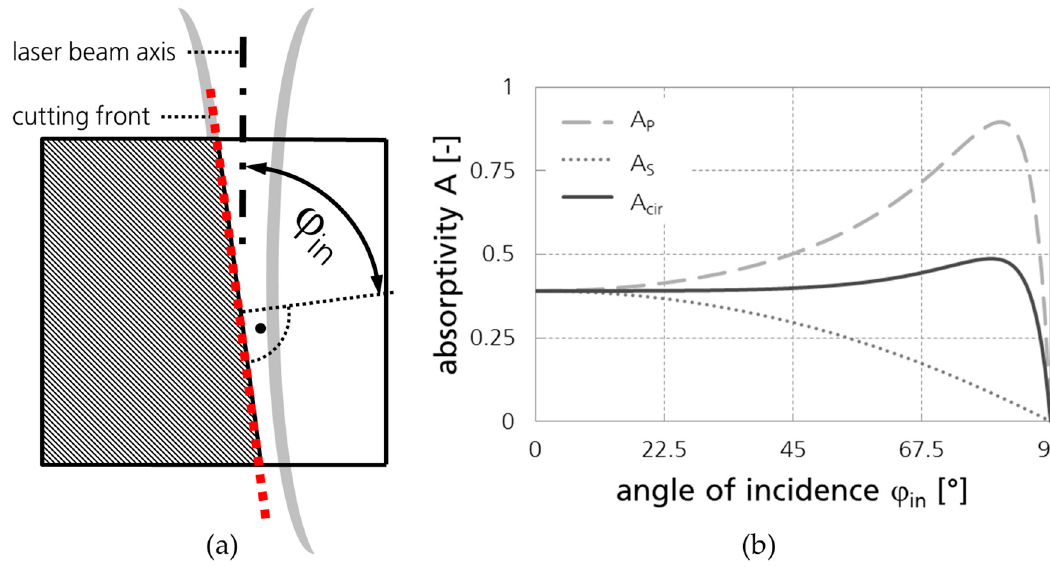
Figure 7. Derivation of absorptivity based on cut front topography: ( a ) Scheme of the angle of incidence ϕ in ; ( b ) Dependence between angle of incidence ϕ in and absorptivity A Cir for liquid iron and radiation wavelength λ = 1.07 µm [2].